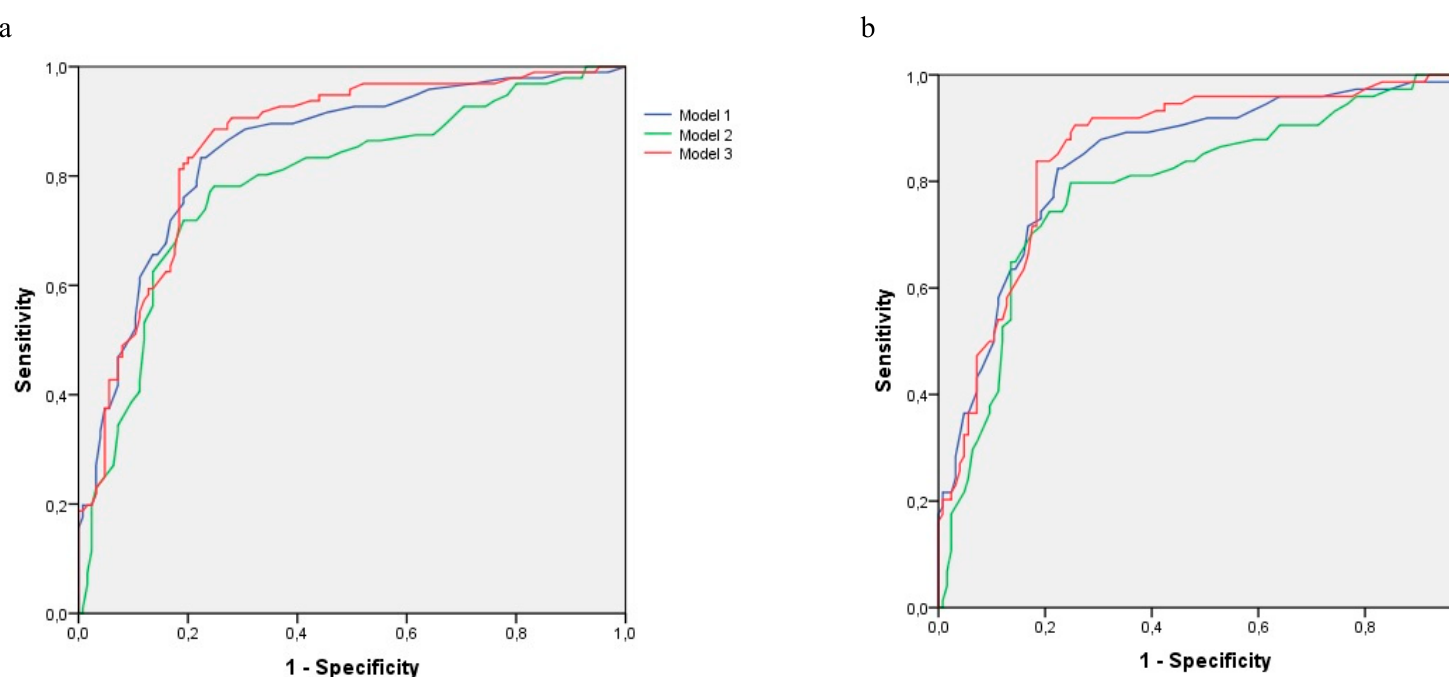
Figure 1. ROC curves for multivariate logistic regression models for dementia and AD outcome variables. ( a ). Outcome Variable: Dementia; ( b ). Outcome Variable: AD.